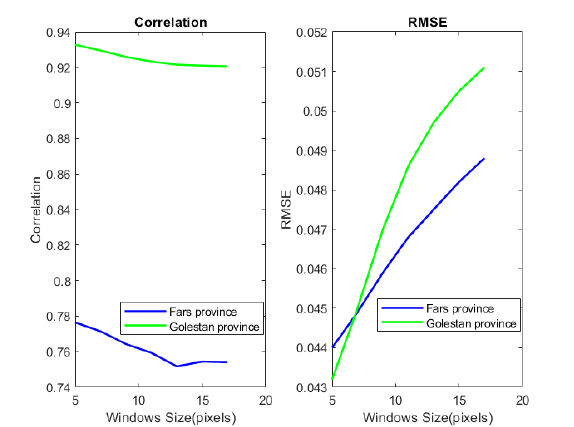
Figure 9 . Effect of increasing the estimation window size on the downscaling